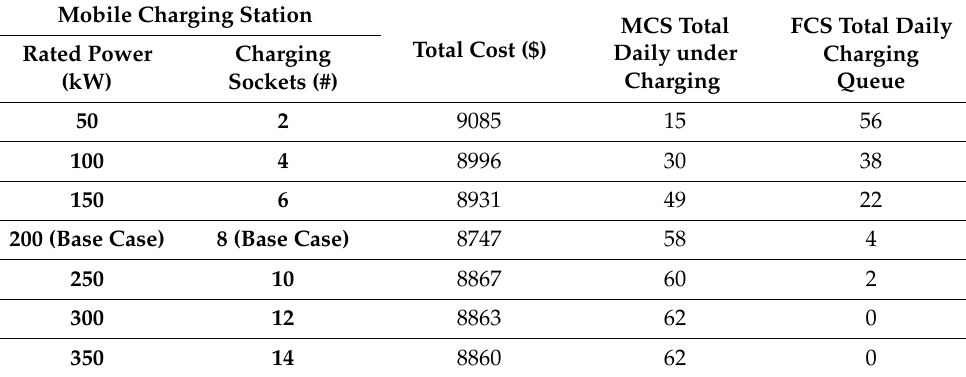
Table 2. Sensitivity of the results with respect to the MCS rated power (charging sockets). Mobile Charging Station